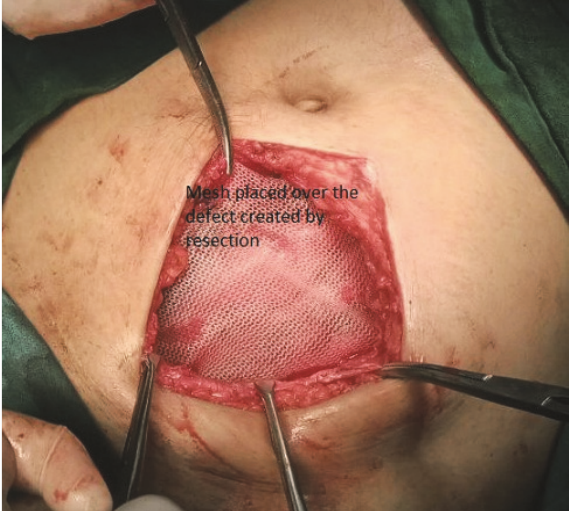
Figure 4: Mesh reconstruction of the defect.